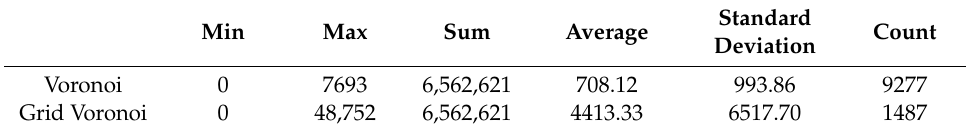
Figure 4. Mobile phone population map in non-work time: ( a ) simple Voronoi; ( b ) Grid Voronoi. Table 3. Demographics of mobile phones in non-work time.